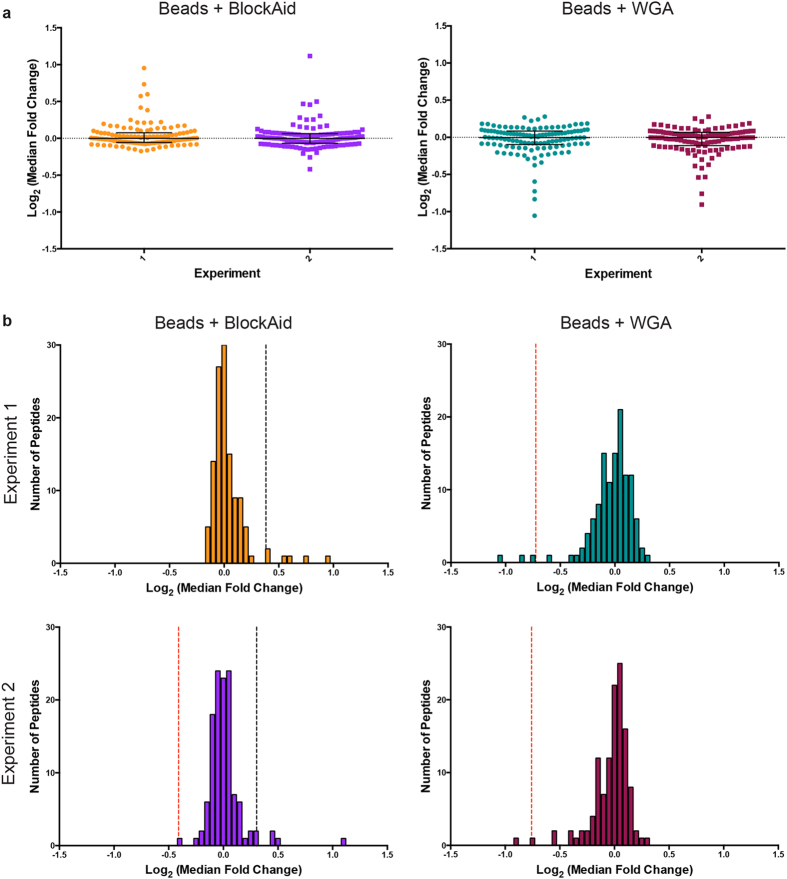
Quantitative phospho-proteomics of erythrocyte response to microbeads.(a) Median fold-change values for high confidence phosphorylated and non-phosphorylated erythrocyte peptides were determined by comparing individual peptide abundances between test (containing added microbeads either pre-incubated with WGA or in the presence of BlockAid) and control (erythrocytes alone) samples. Values were transformed by median centering for the two conditions. Bars represent the global median and inter-quartile range for each sample set. (b) Histograms of each erythrocyte bead assay subjected to quantitative phospho-proteomics, displaying the transformed log2 (median fold change) values for each phosphorylated and non-phosphorylated erythrocyte peptide detected. Outlier boundaries, produced using the ROUT method, are marked with the dashed lines. Black dashed line represents upper boundary, where peptides with values above this line considered outliers, while the red dashed line marks the lower boundary, where peptides with values lower than this value identified as outliers. Histogram bin width is 0.05.